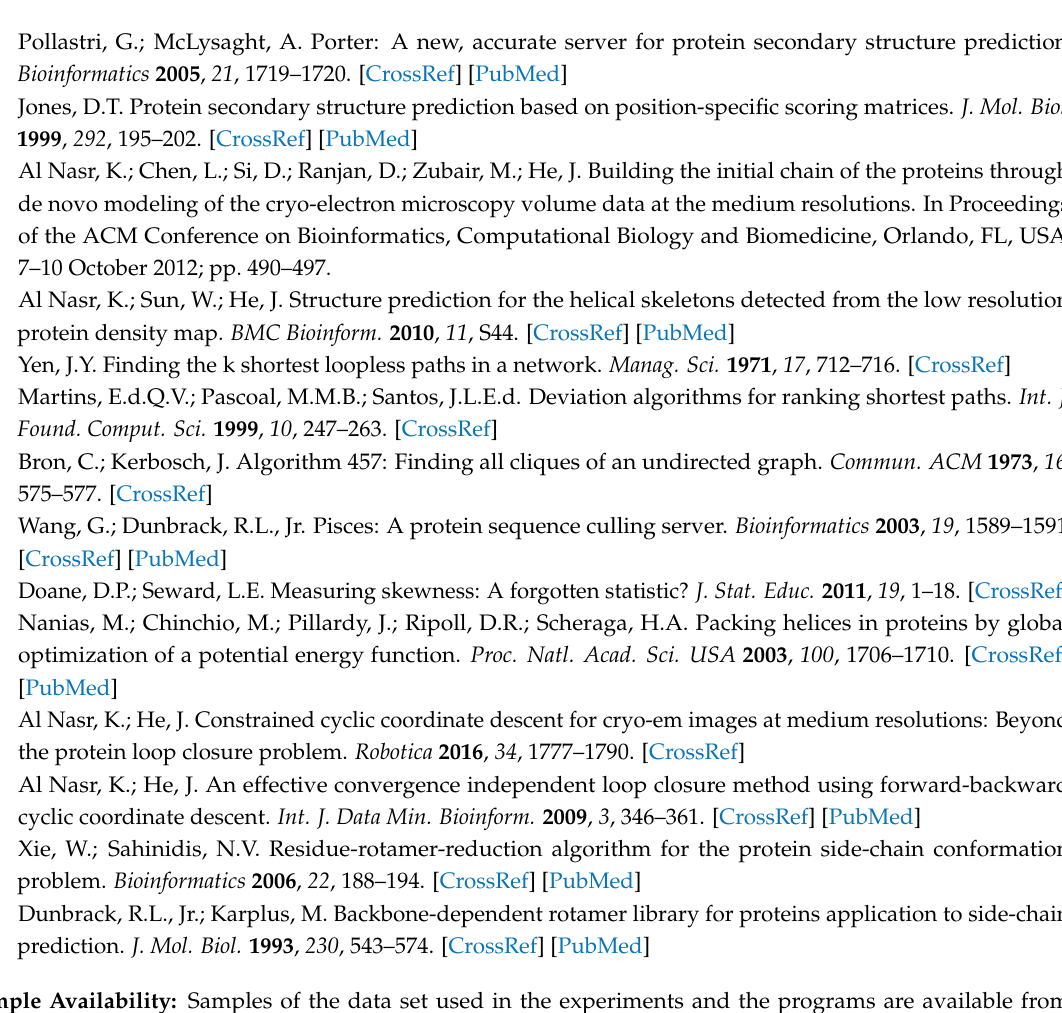
Sample Availability: Samples of the data set used in the experiments and the programs are available from the